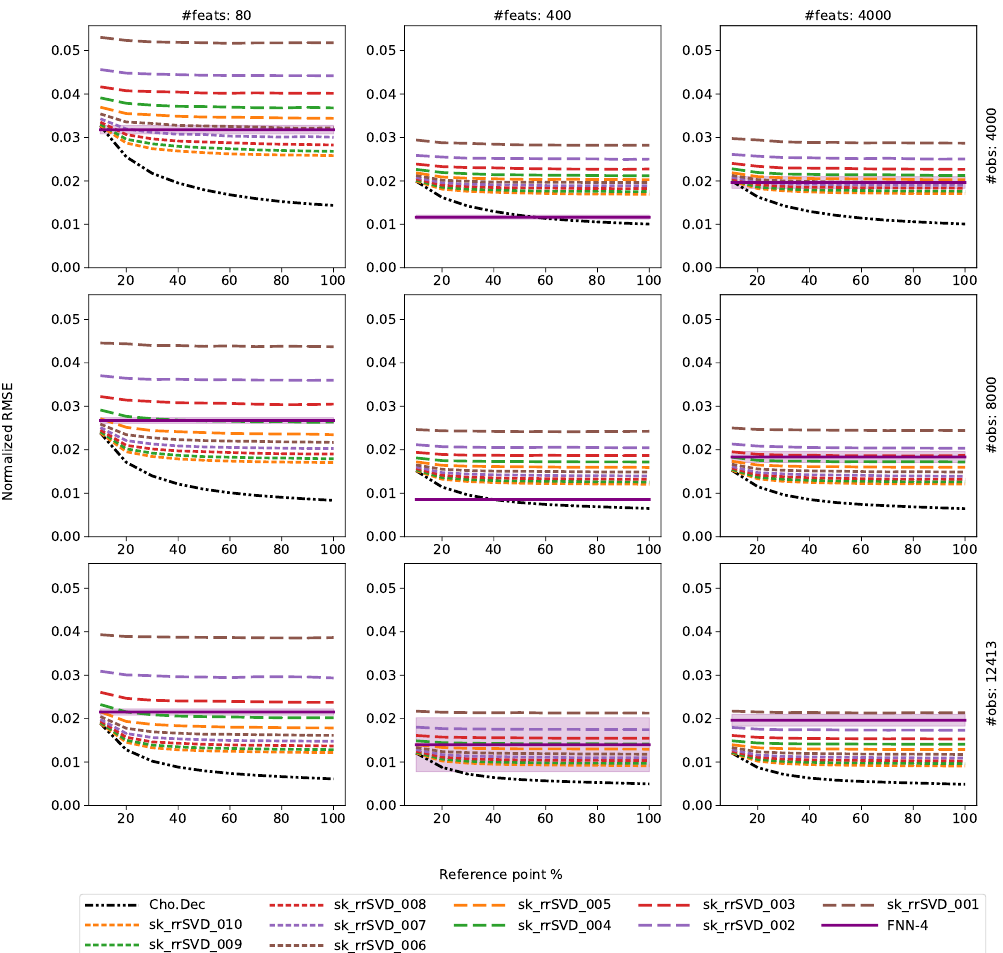
Figure A9. Same as Figure A7 but, for readability, without FNN-2 . In addition, the Y–axis scale is same in each